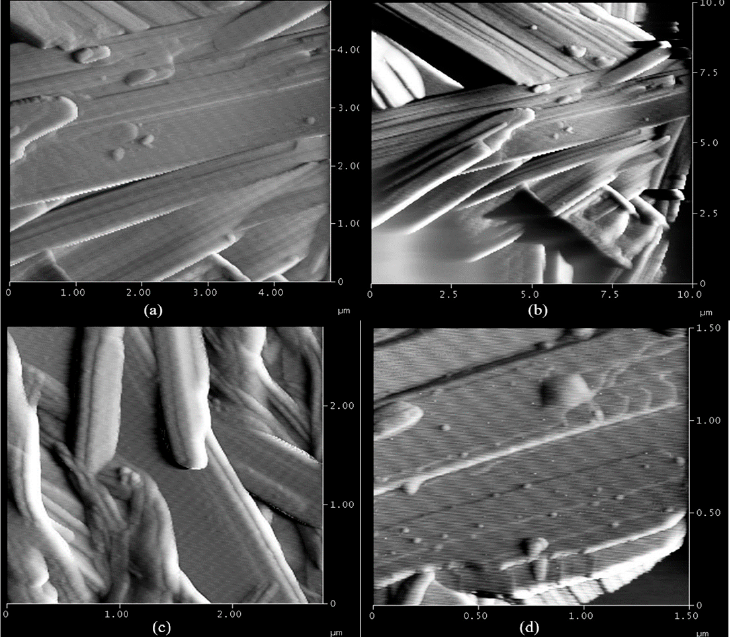
Figure 5. AFM images of the gels formed by compound 7c and 7d. ( a , b ) 7c in DMSO:H 2 O (1:1) at 3.3 mg/mL; ( c , d ) 7d in EtOH:H 2 O (1:1) at 2.8 mg/mL.